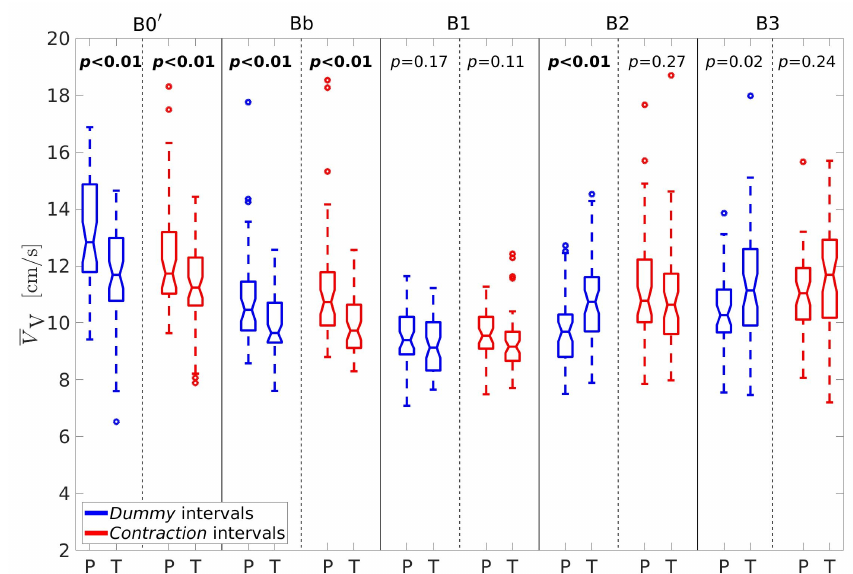
Figure 7. Box plots of the average conduction velocity amplitudes in the vertical direction, V V . P—preterm intervals, T—term intervals.